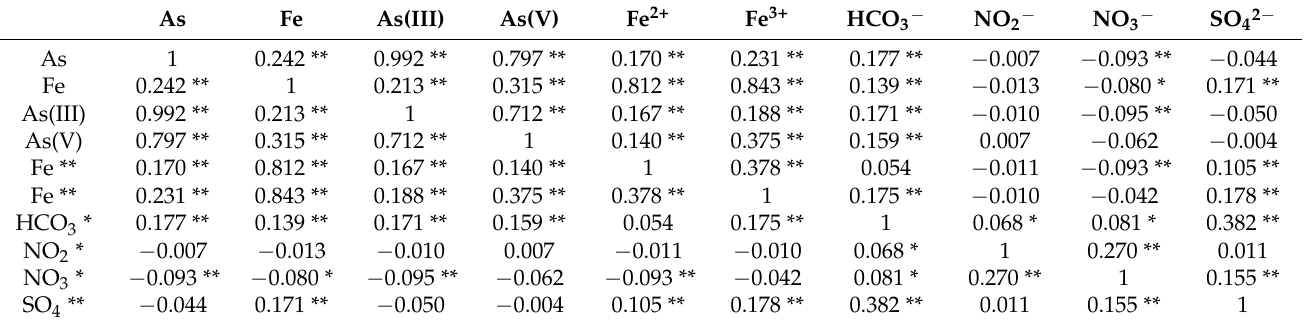
Table 4. Pearson correlation analysis between As and the main redox ions in the Hetao Plain ( n = 974).